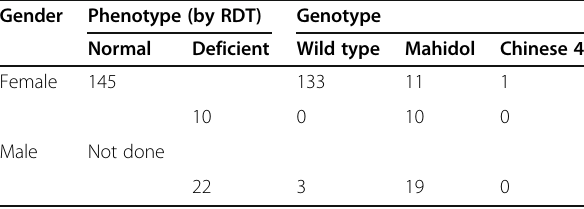
Table 4 Comparison of G6PD genotypes and phenotypes Gender Phenotype (by